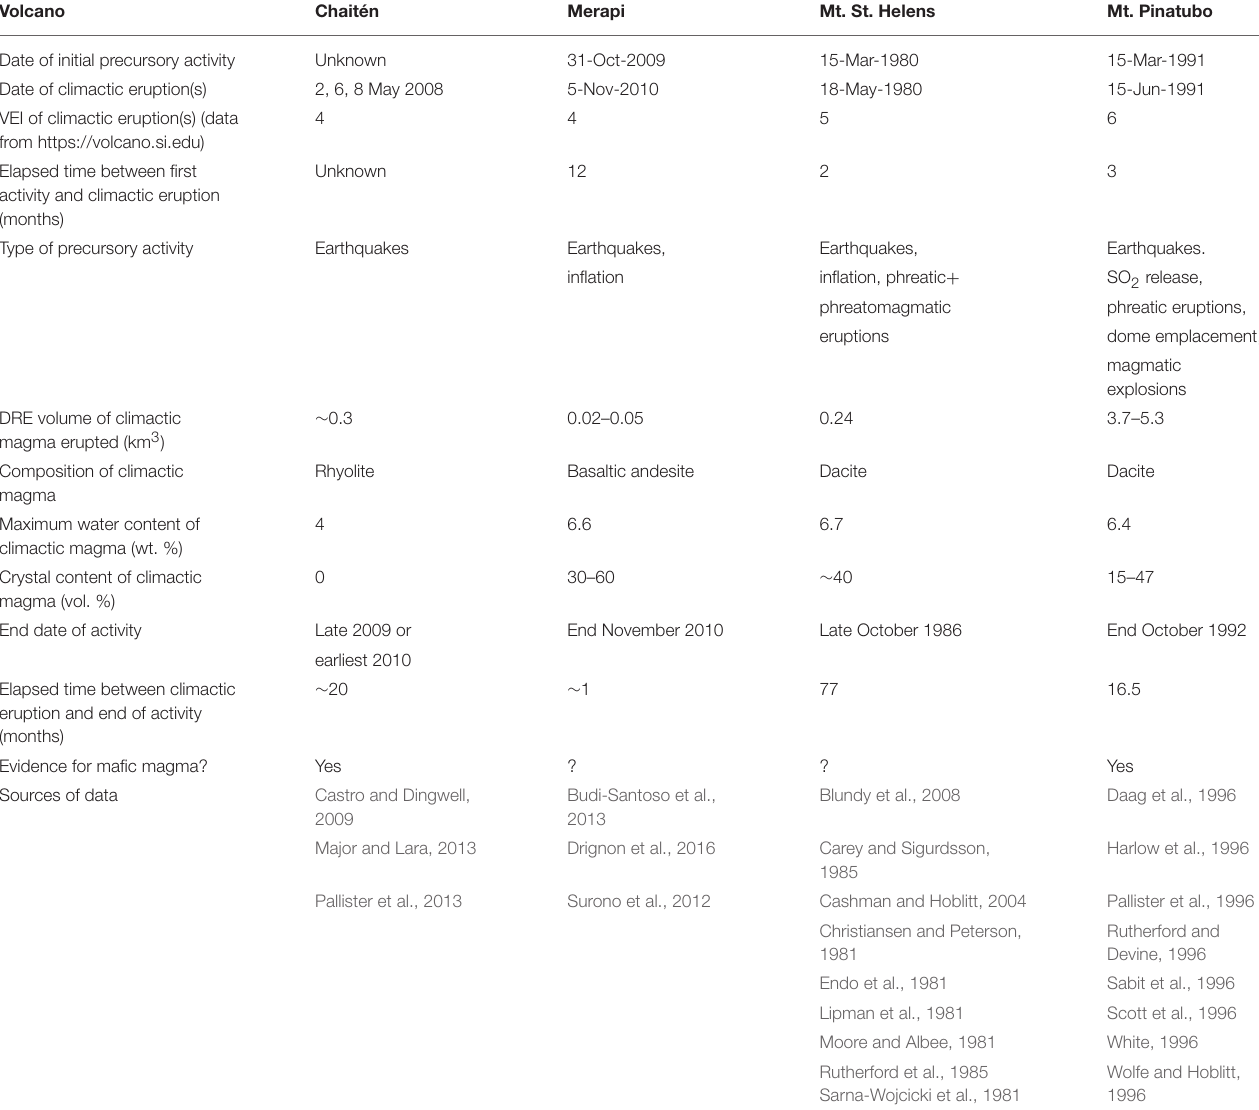
TABLE 1 | Characteristics of fast volcanic